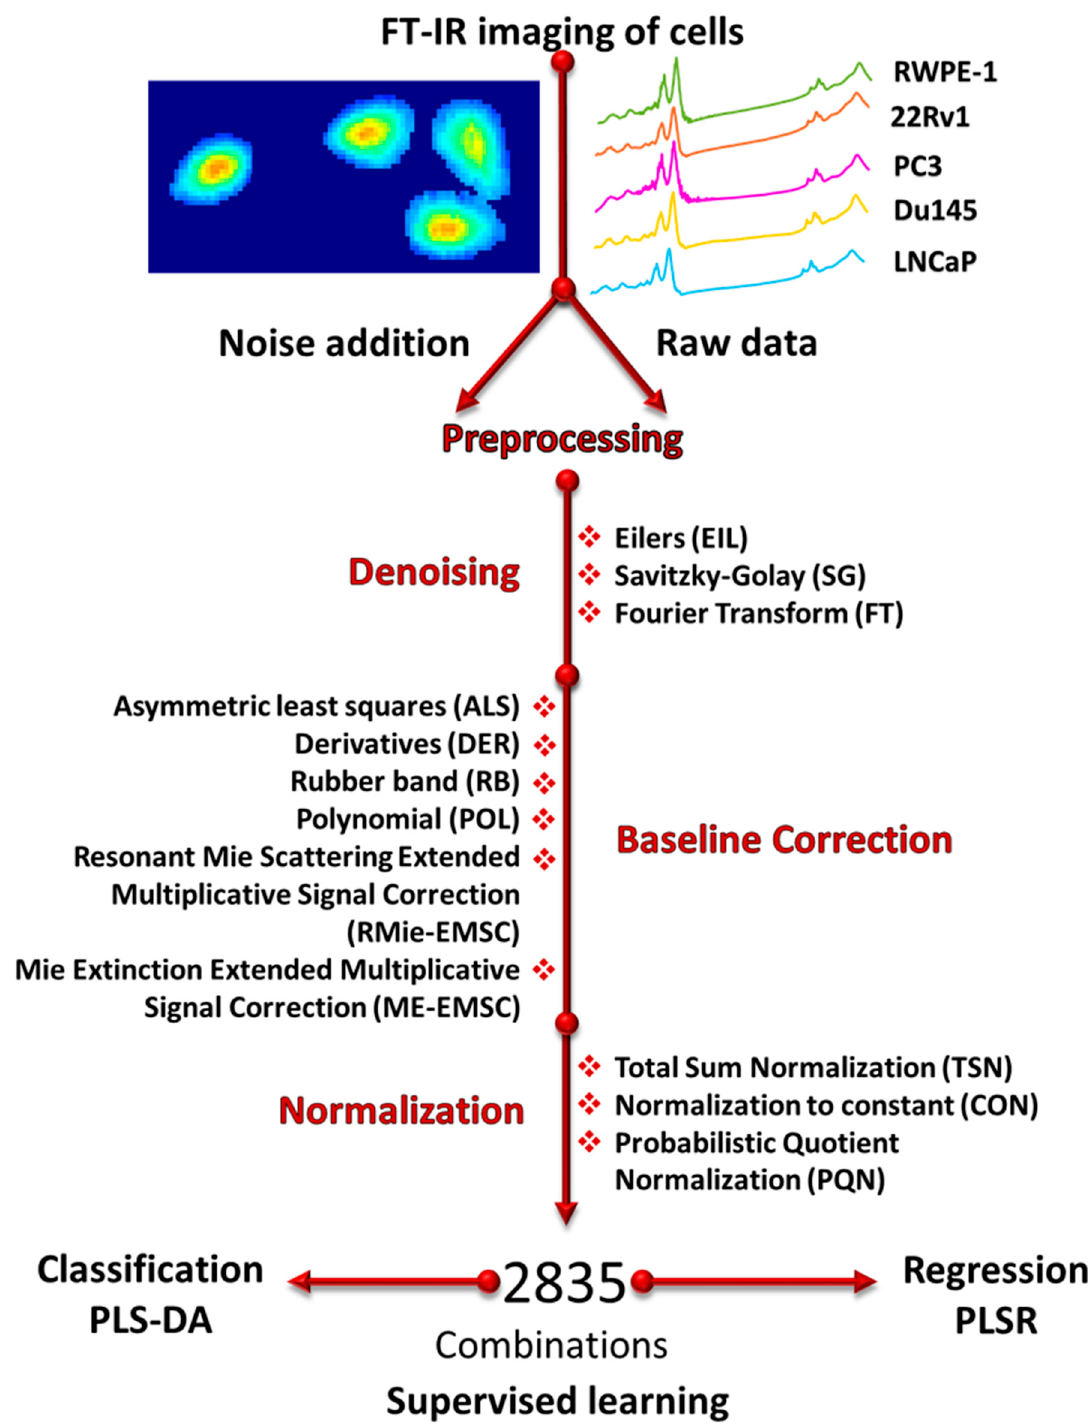
Figure 1. A scheme of the preprocessing steps—five prostate cell lines were imaged with FT-IR, then white noise was added to the original spectra. Raw data and data with added noise were preprocessed in the following order: denoising → baseline correction → normalization. Individual methods coming from one preprocessing step were combined with each method from the remaining two preprocessing steps. Taking into account the above and the number of parameters adjusted for each method, the number of combinations (data sets) was equal to 2835. All of these combinations were then used to create a classifier discriminating cell lines and a regression model of class assignments giving more detail about the relative importance of different preprocessing factors and parameters.